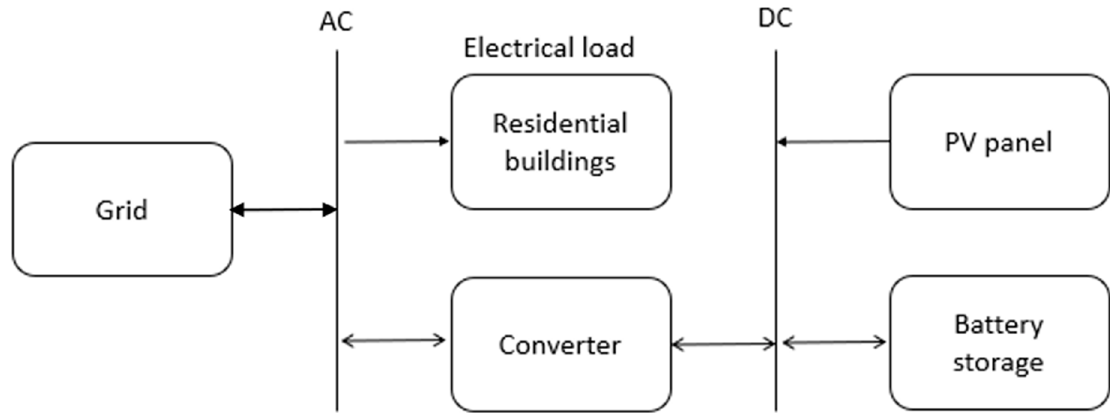
Figure 2. Integrated energy system (IES) configuration.